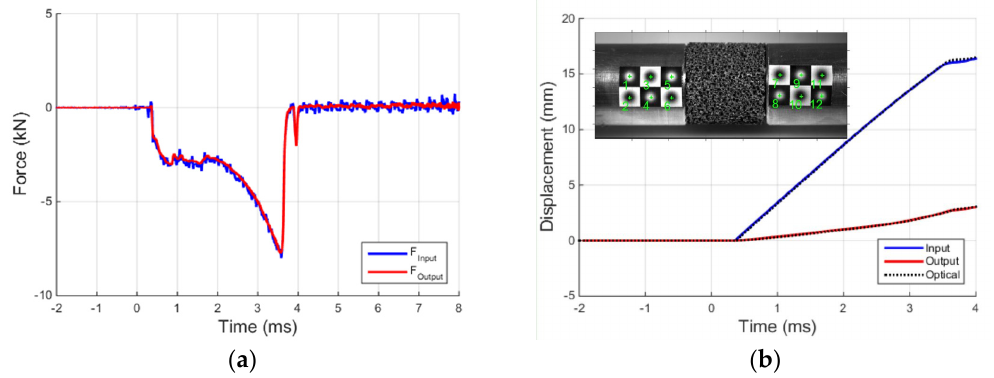
Figure 9. ( a ) Equilibrium check at specimen ‐ bars interfaces; and ( b ) comparison between displacements obtained with Hopkinson bar theory and with the fast tracking optical algorithm.